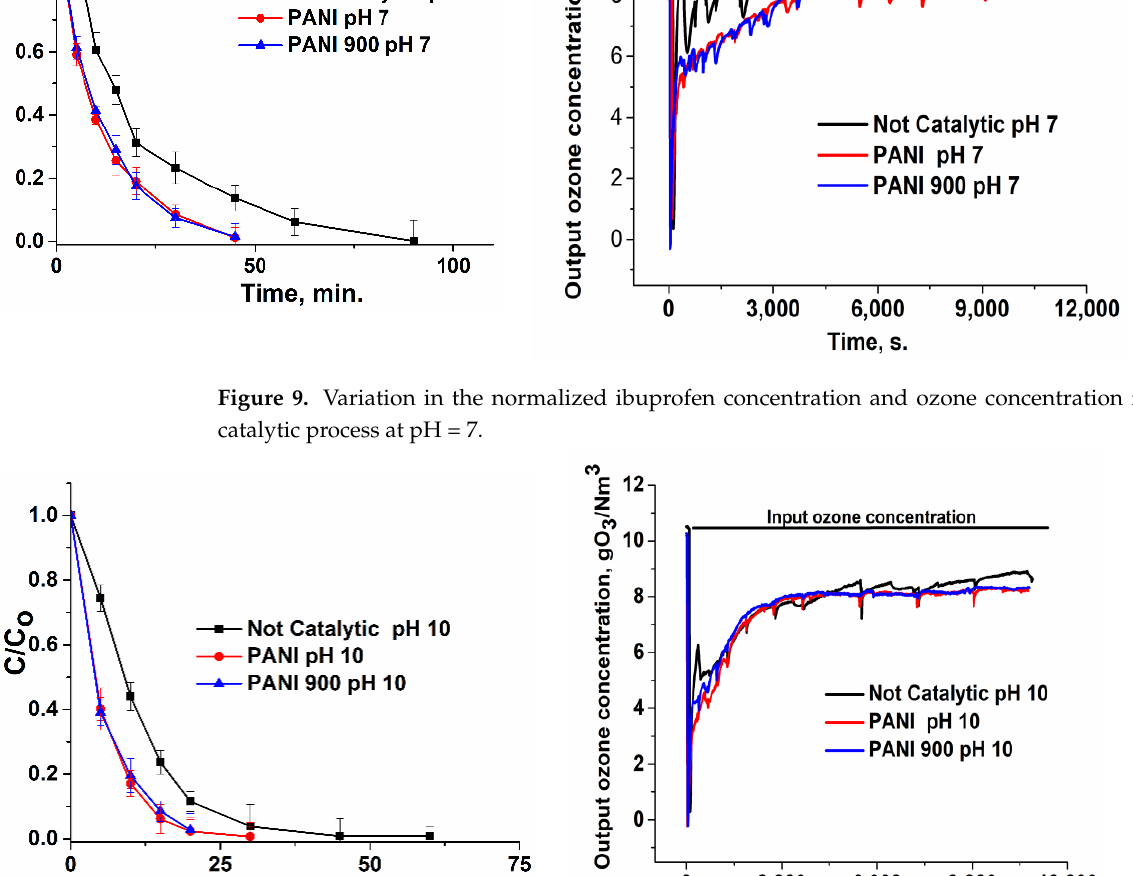
Figure 10. Variation in the normalized ibuprofen concentration and ozone concentration for the catalytic process at pH = 10.